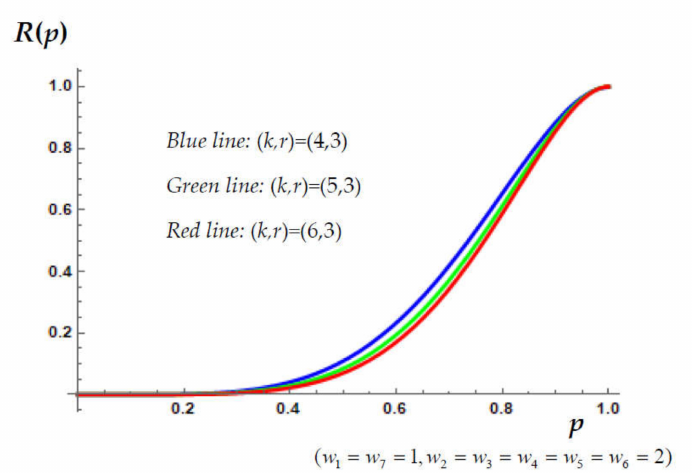
Figure 2. The reliability polynomials weighted-3-within-consecutive- k -out-of- n : F systems of order